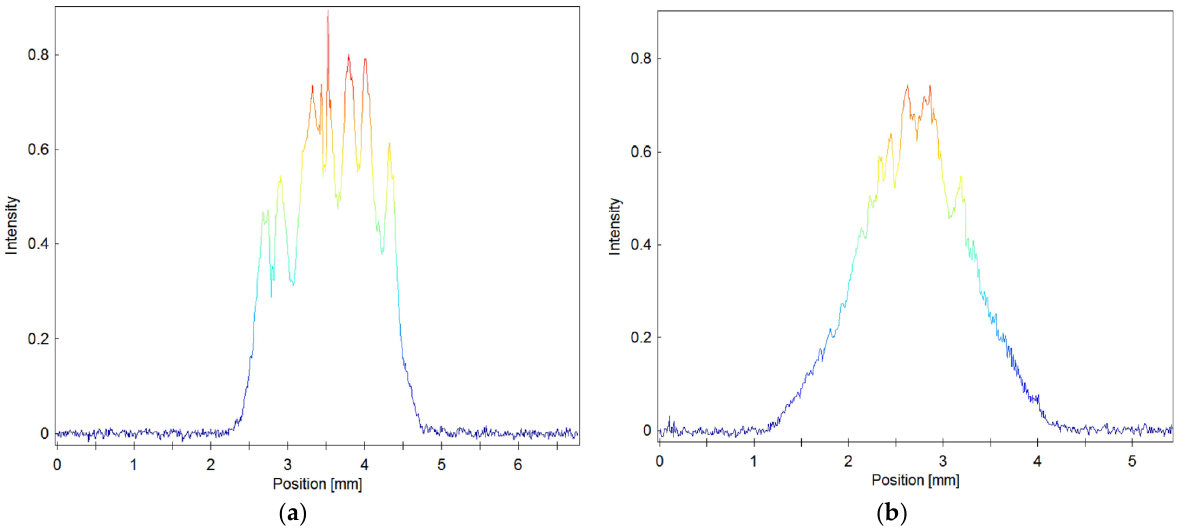
Figure 2. Blue LD beam profile characteristics: ( a ) X cross section; ( b ) Y cross section.